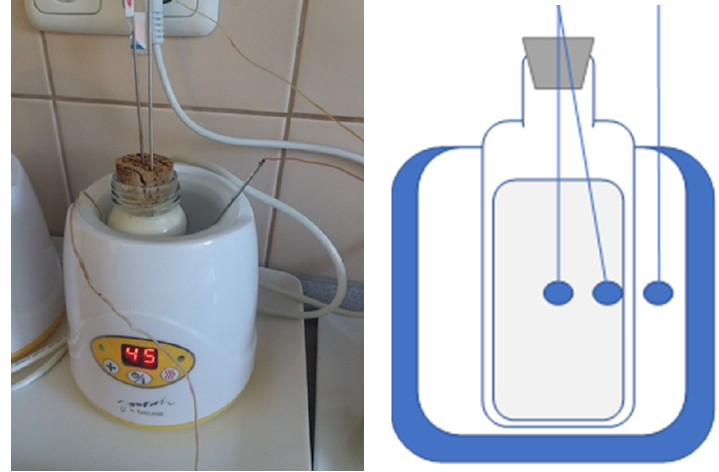
Figure 4. Temperature measurement during warming of bottles containing thawed PBM in a warming device adjusted to 45 °C ( left ); schematic of sensor positions ( right ).